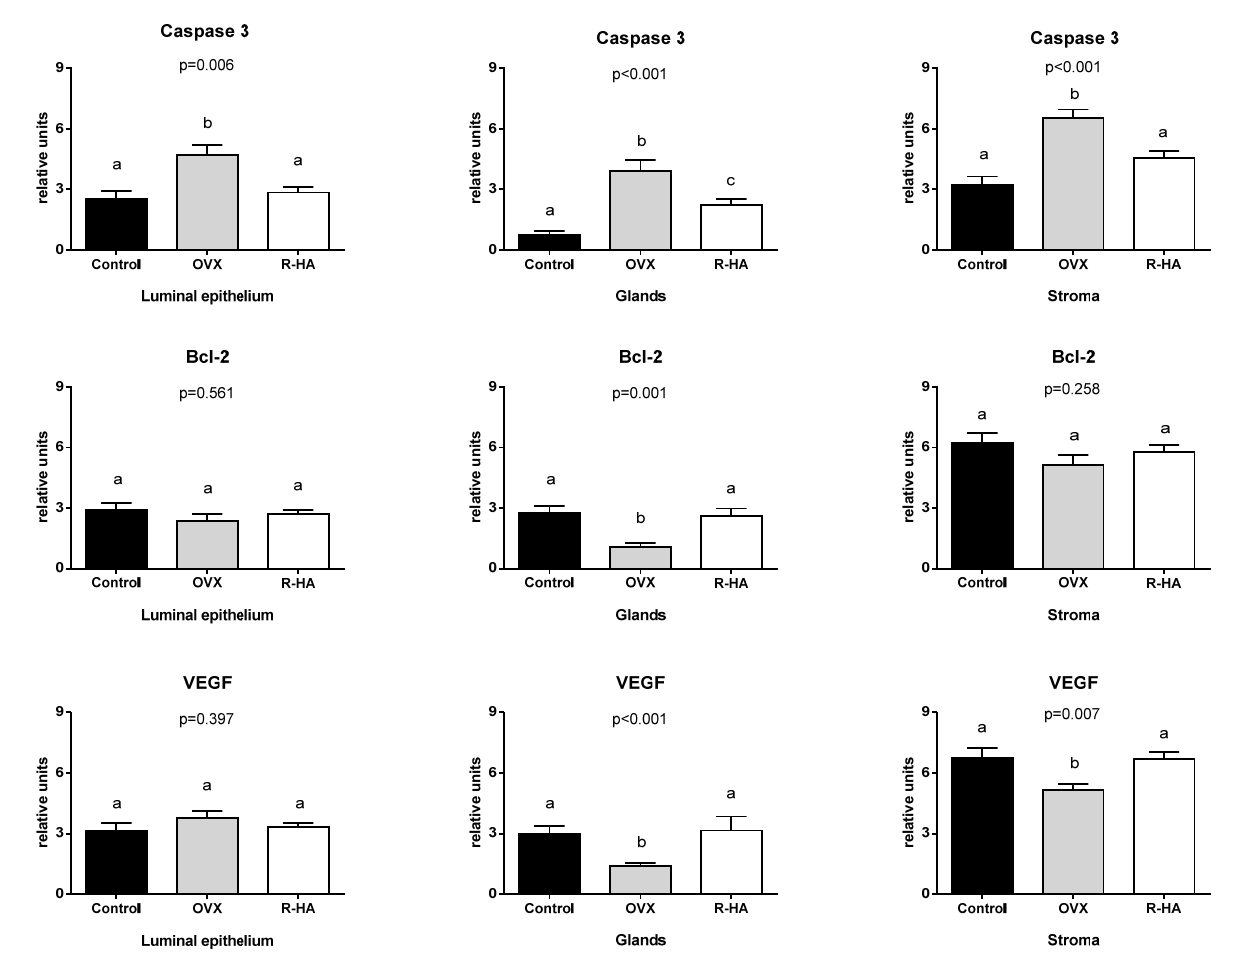
Figure 6. R-HA treatment attenuates proapoptotic changes in endometrium and recovers Bcl-2 and VEGF expression. Data are presented as the M ± SEM. One-way ANOVA with post hoc Tukey’s test for multiple comparisons was performed for data analysis. a, b, c values on the same row with different superscript letters show significant differences in p < 0.05.